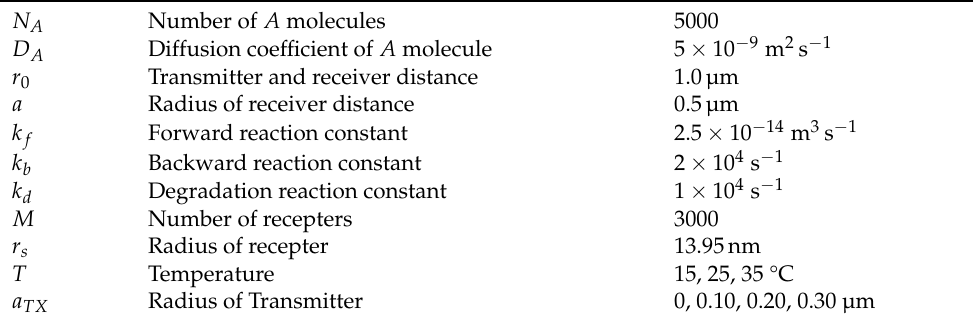
Table 1. Channel parameters of diffusive molecular